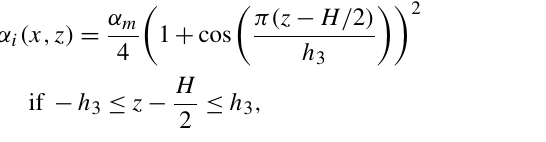
Table 4. Performance of simulations performed with the Upwind, VL, PPM and DL99 vertical advection schemes relative to the exact solution for Case 2: percent relative error in (cid:107)·(cid:107) 1 and (cid:107)·(cid:107) 2 and percent of total tracer mass contained in the correct